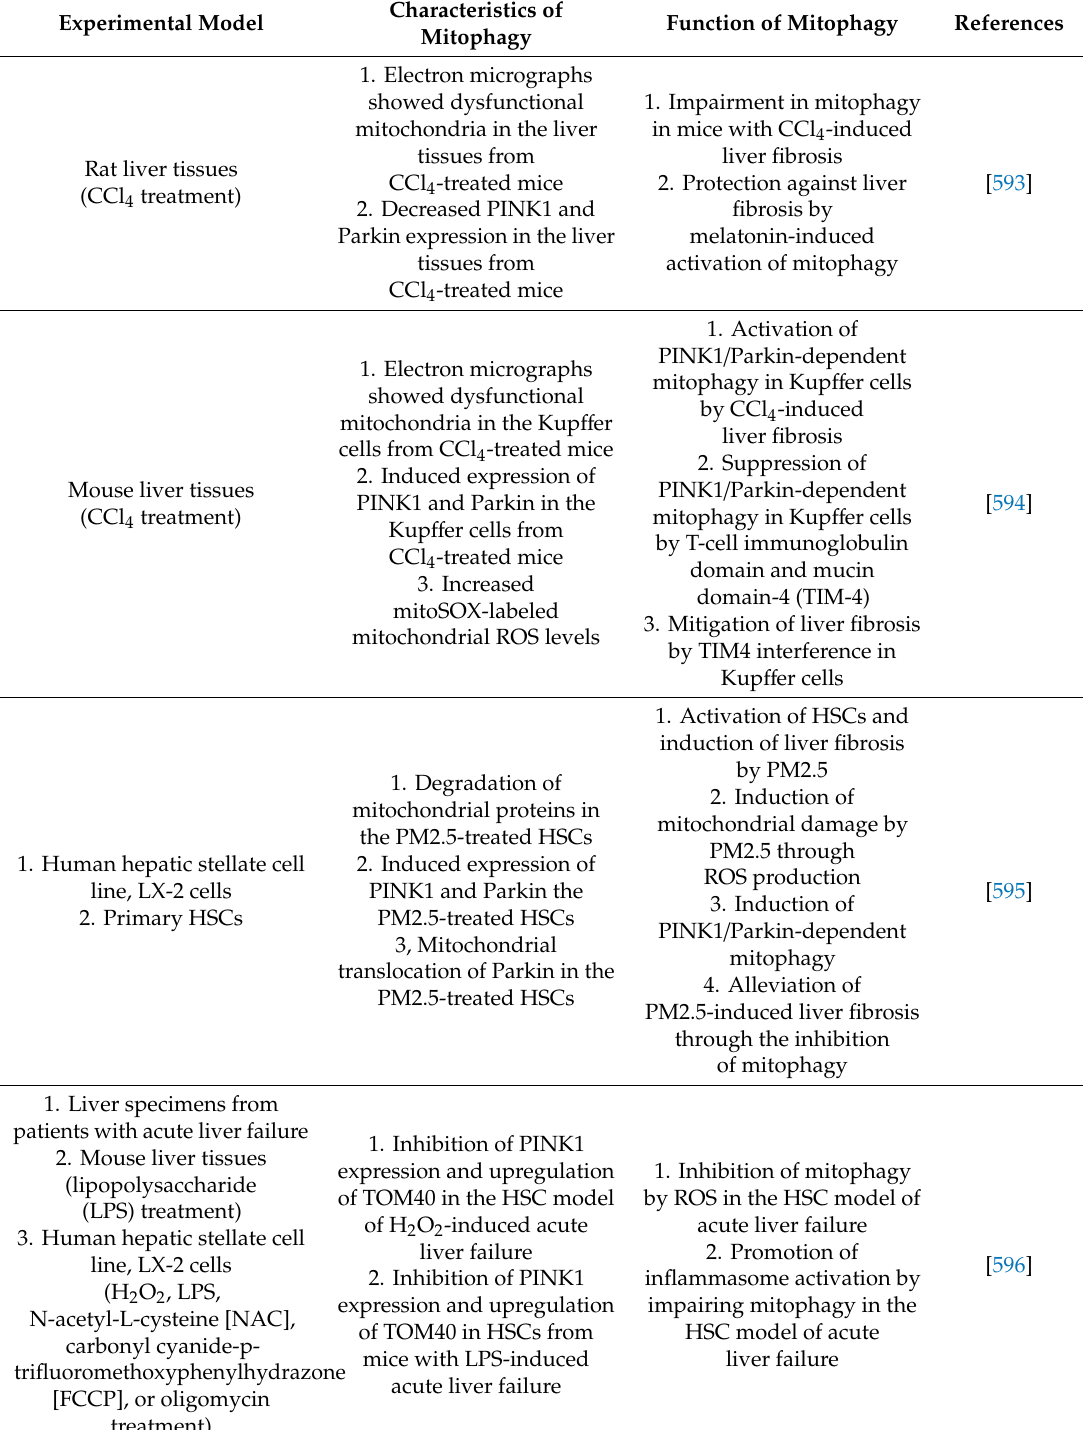
Table 6. Summary of the roles of mitophagy in other liver